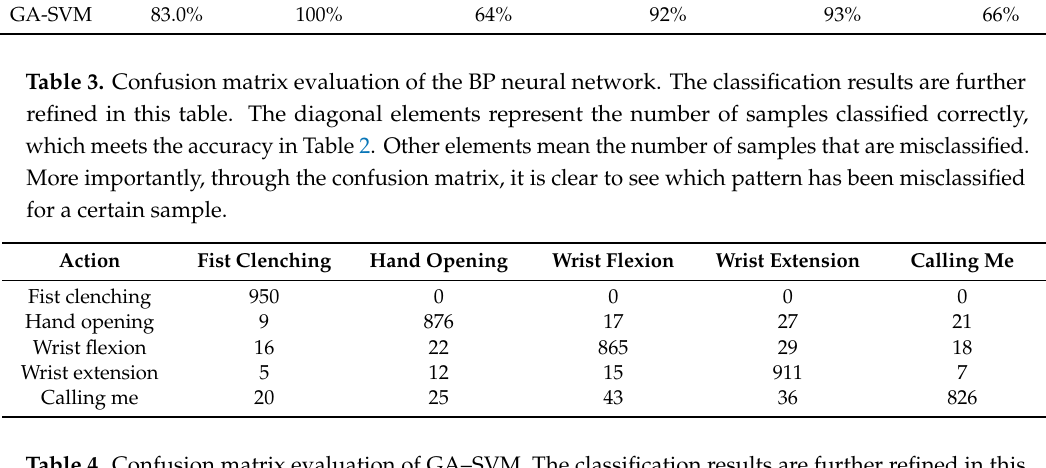
Table 4. Confusion matrix evaluation of GA–SVM. The classification results are further refined in this table. Similarly, the diagonal elements represent the number of correctly classified samples, which meets the accuracy in Table 2 as well. Other elements mean the number of samples that are misclassified. It is obvious that the classification accuracy of the GA–SVM is lower than that of the BP neural network, and the misjudged samples are greater in